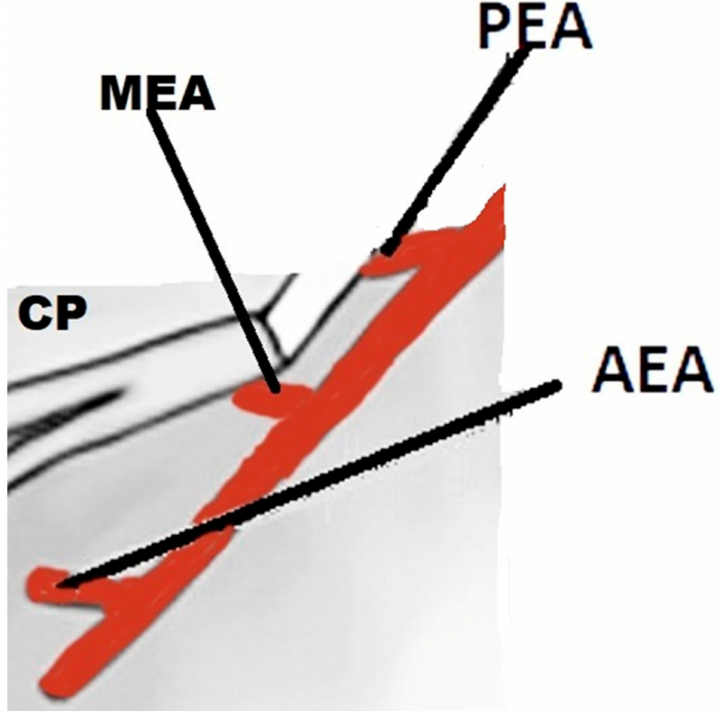
Figure 1. Relation of the ethmoidal arteries at the left cribriform plate to the anterior. Ethmoidal artery (AEA) running in front and the posterior ethmoidal artery (PEA) at the back. Middle ethmoidal artery (MEA), when present, is located between the anterior and posterior ethmoidal arteries. AEA, anterior ethmoidal artery; MEA, middle ethmoidal artery; PEA, posterior ethmoidal artery; and CP, cribriform